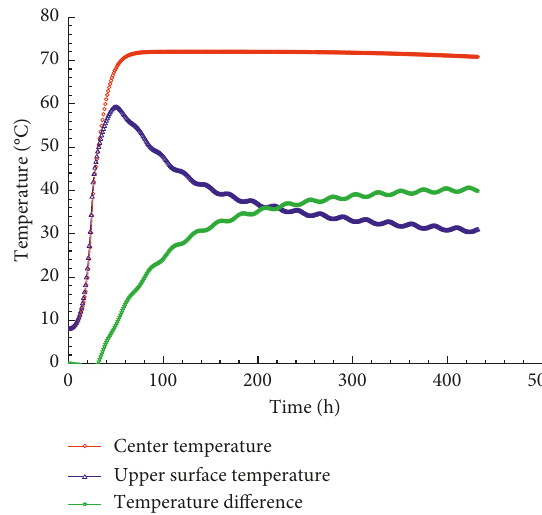
Figure 18: Temperature difference between the core and the upper surface of the 9.9 m thick foundation.